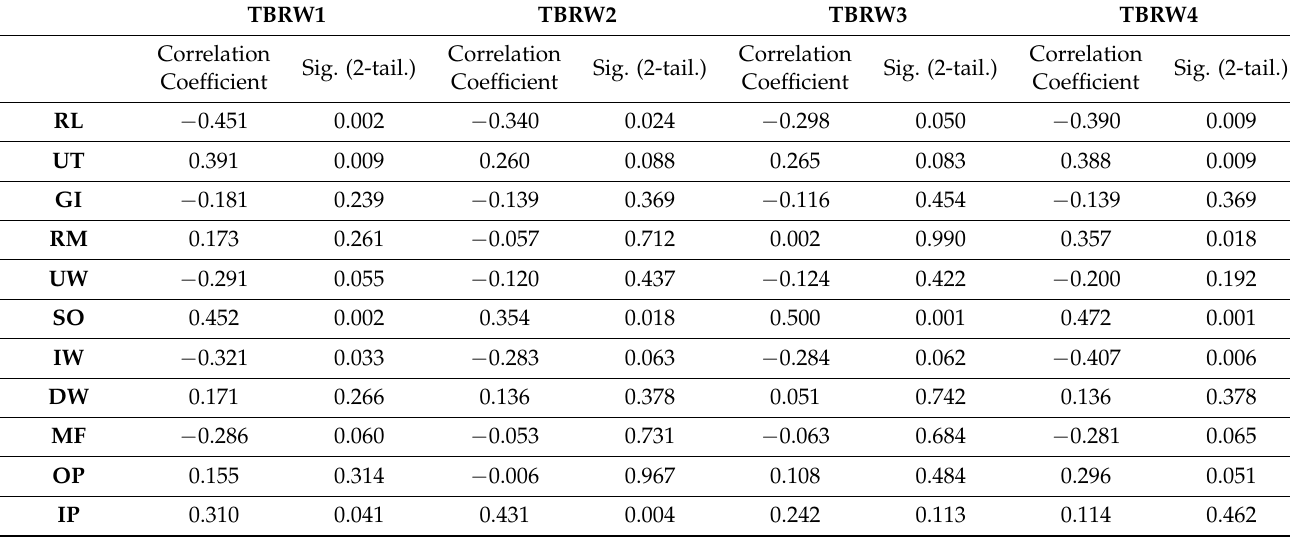
Table A3. Spearman’s ranks for correlations between top benefits of remote work (TBRW) and aspects of operational activities. TBRW1 TBRW2 TBRW3 TBRW4 Correlation